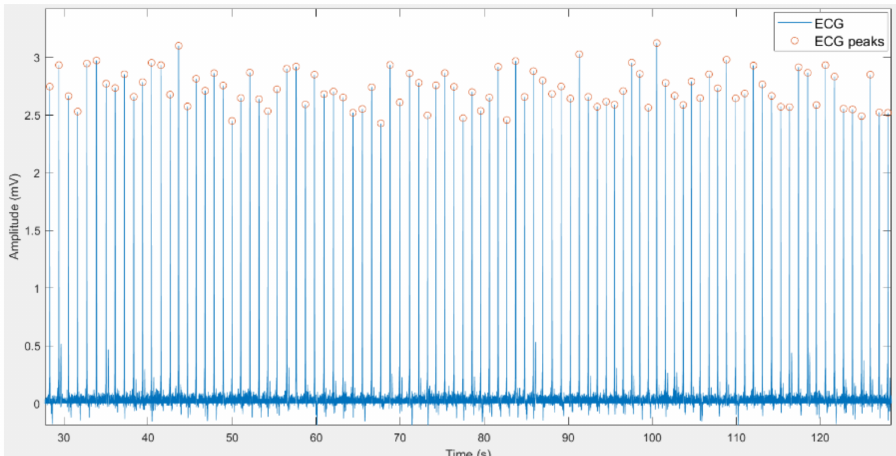
Figure 10. R-peaks detection in signals from the SHIMMER database.